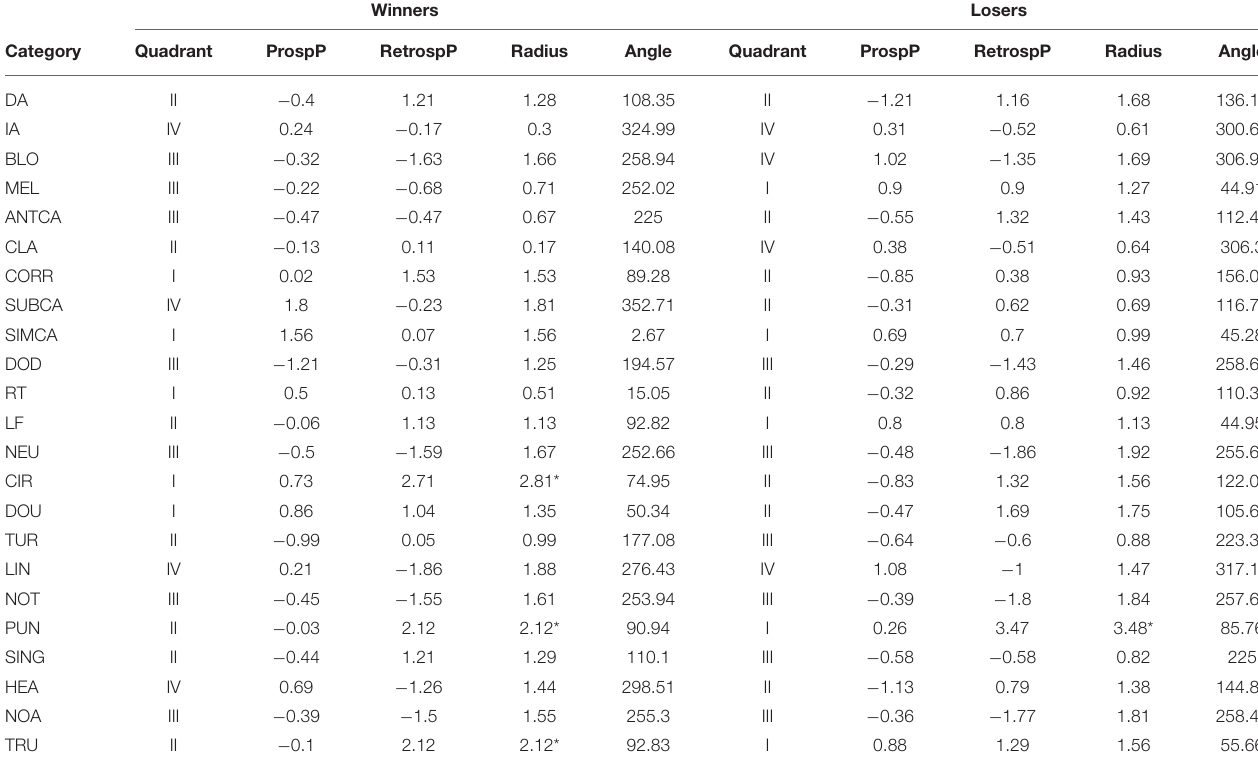
TABLE 6 | Results of the polar coordinate analysis for the 2P focal category in winners and losers. Winners